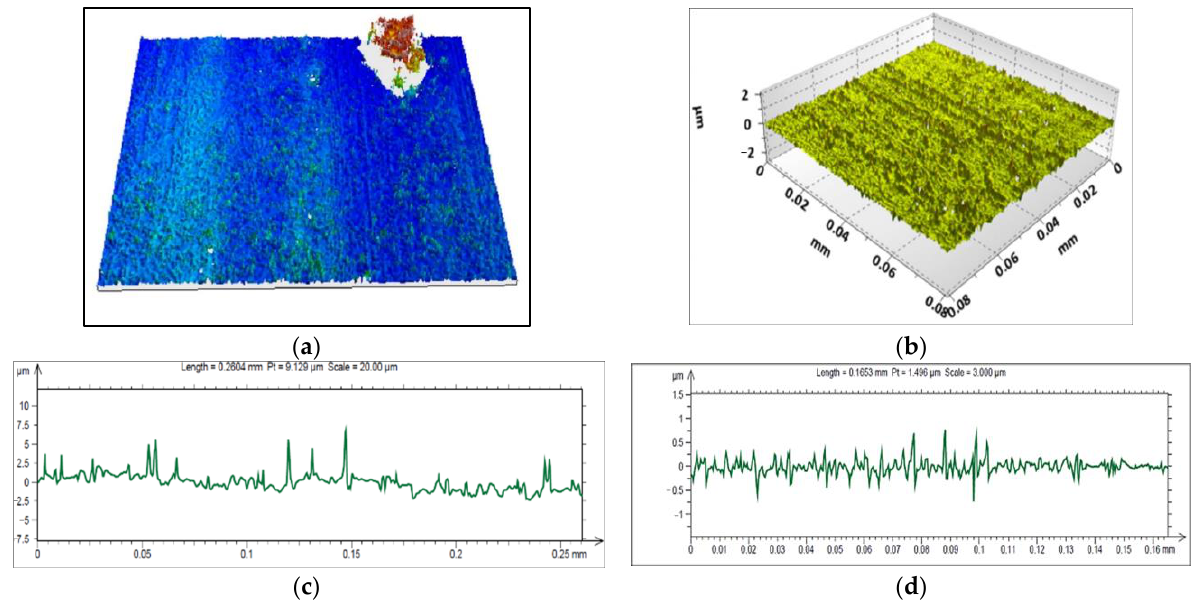
Figure 11. Differentiation of three − dimensional surface roughness, two − dimensional surface profile initially and after burnishing at 600 rpm. ( a ) 3D profile of initial surface, ( b ) 3D profile of burnished surface, ( c ) 2D profile of initial surface, ( d ) 2D profile of burnished surface.